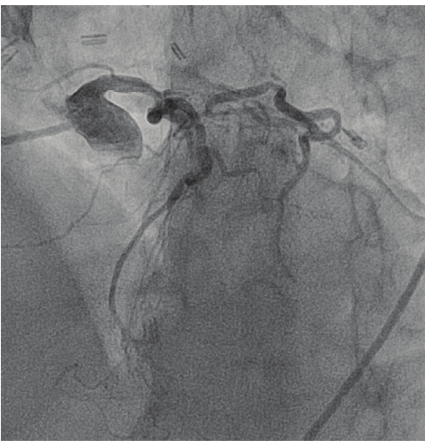
Figure 1: Angiography of left coronary system shows extensive native disease.